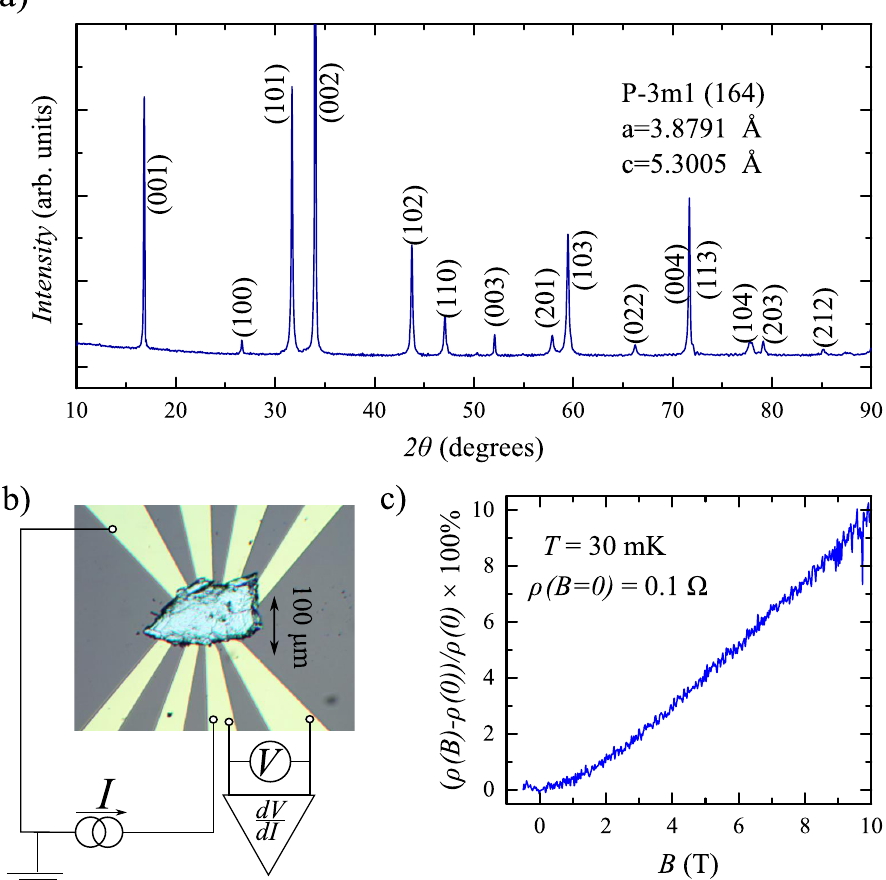
Figure 1. (Color online): ( a ) X-ray powder diffraction pattern, which confirms a single-phase NiTe 2 with P-3m1 (164) space group (a = b = 3.8791 Å, c = 5.3005 Å). ( b ) A top-view image of the sample with Au leads. A thick (0.5 µ m) NiTe 2 mechanically exfoliated flake is placed on the pre-defined Au leads pattern to form 5 µ m separated NiTe 2 -Au junctions with a lateral size of approximately 10 µ m. To investigate a single NiTe 2 -Au junction, electron transport is measured by a standard three-point technique. ( c ) The known non-saturating magnetoresistance for NiTe 2 material [33,34] is reproduced for our samples in four-point longitudinal magnetoresistance measurements. The four- point resistance is finite ( ≈ 0.1 Ω ) even in the zero field. The data are obtained at T = 30 mK for the normal magnetic field